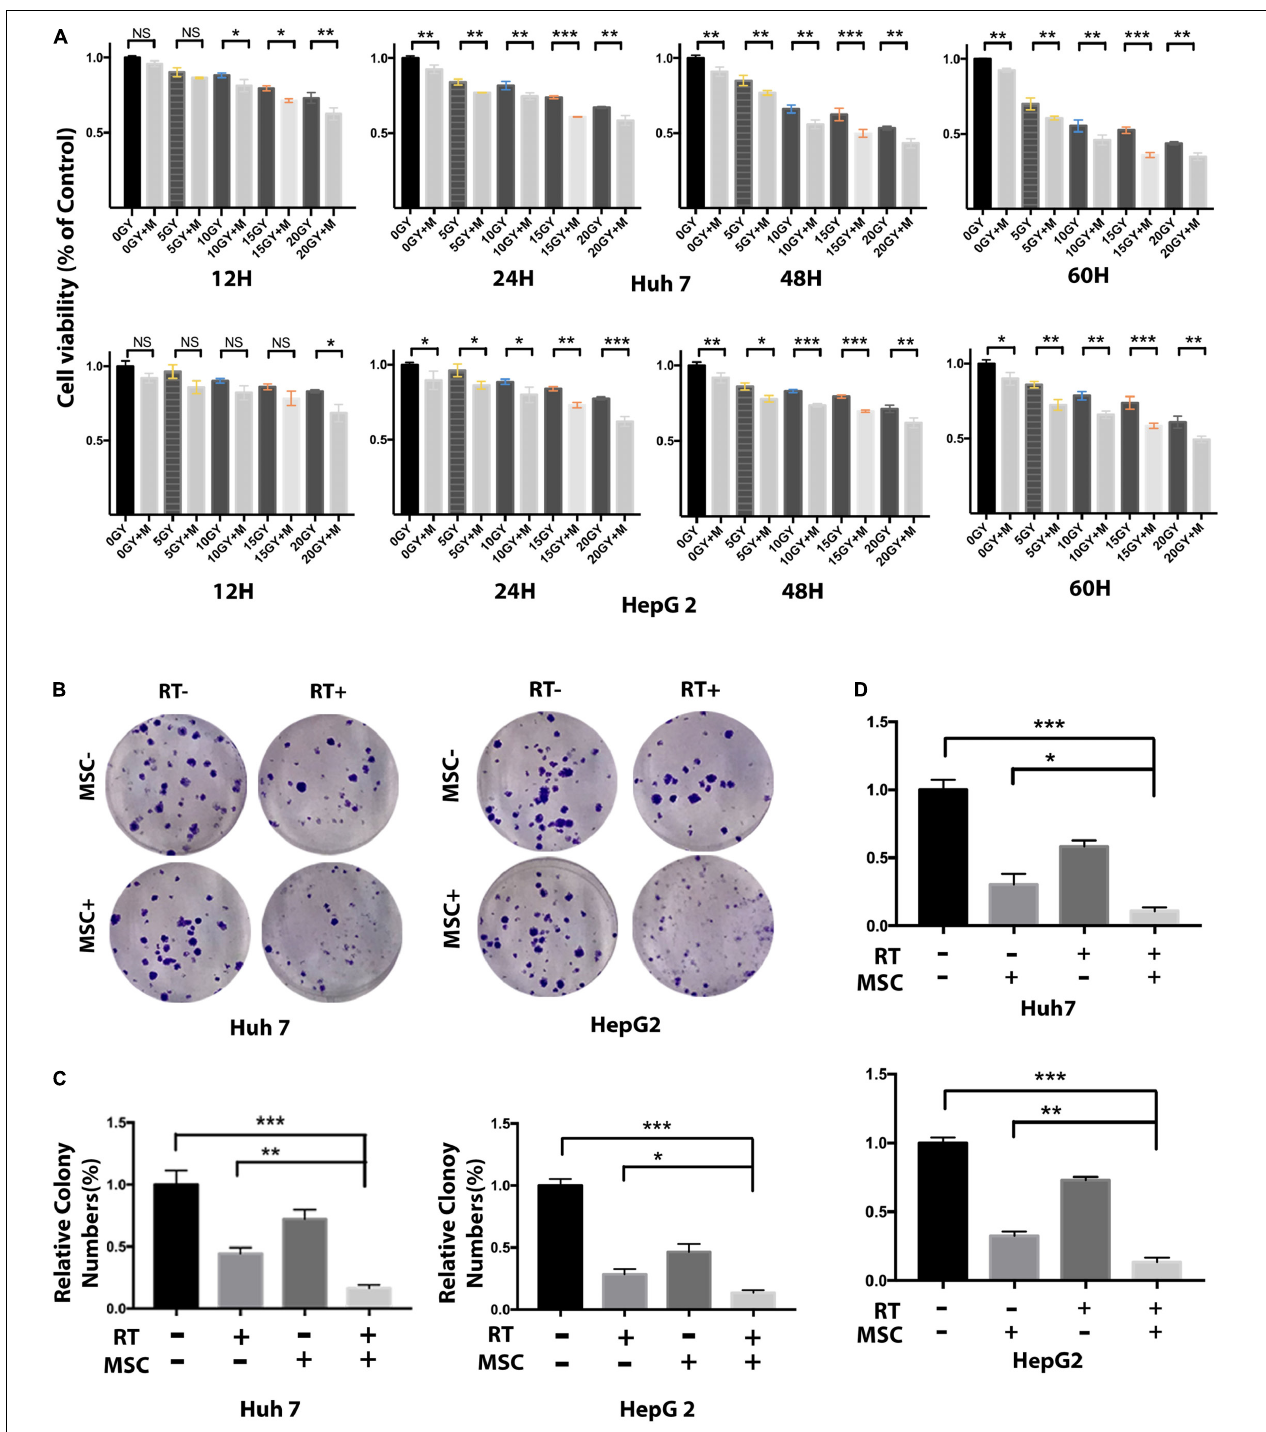
FIGURE 2 | AT-MSC augments the effects of RT against HCC cells proliferation and sphere-forming. (A) Cell viability of Huh7 and HepG2 cells treated with radiation and/or AT-CM for 12, 24, 48, and 60 h was assessed by CCK8 assay. Data represent the means ± SD of three independent experiments ( ∗∗ P < 0.01, ∗∗∗ P < 0.001). (B,C) Huh7 cells treated with RT with or without AT-CM were cultured on ultra-low attachment plates to assess sphere-formation ability. Representative images are shown. The results are expressed as means ± SD of three independent experiments ( ∗ P < 0.05, ∗∗ P < 0.01, ∗∗∗ P < 0.001). (D) The effect of AT-MSCs co-culture with human HCC cell line Huh7 and HepG2 after irradiation. Tumor cells grown as colonies in a monolayer culture. The initial size of the colonies was measured and successive treatments was applies for 7 days more.